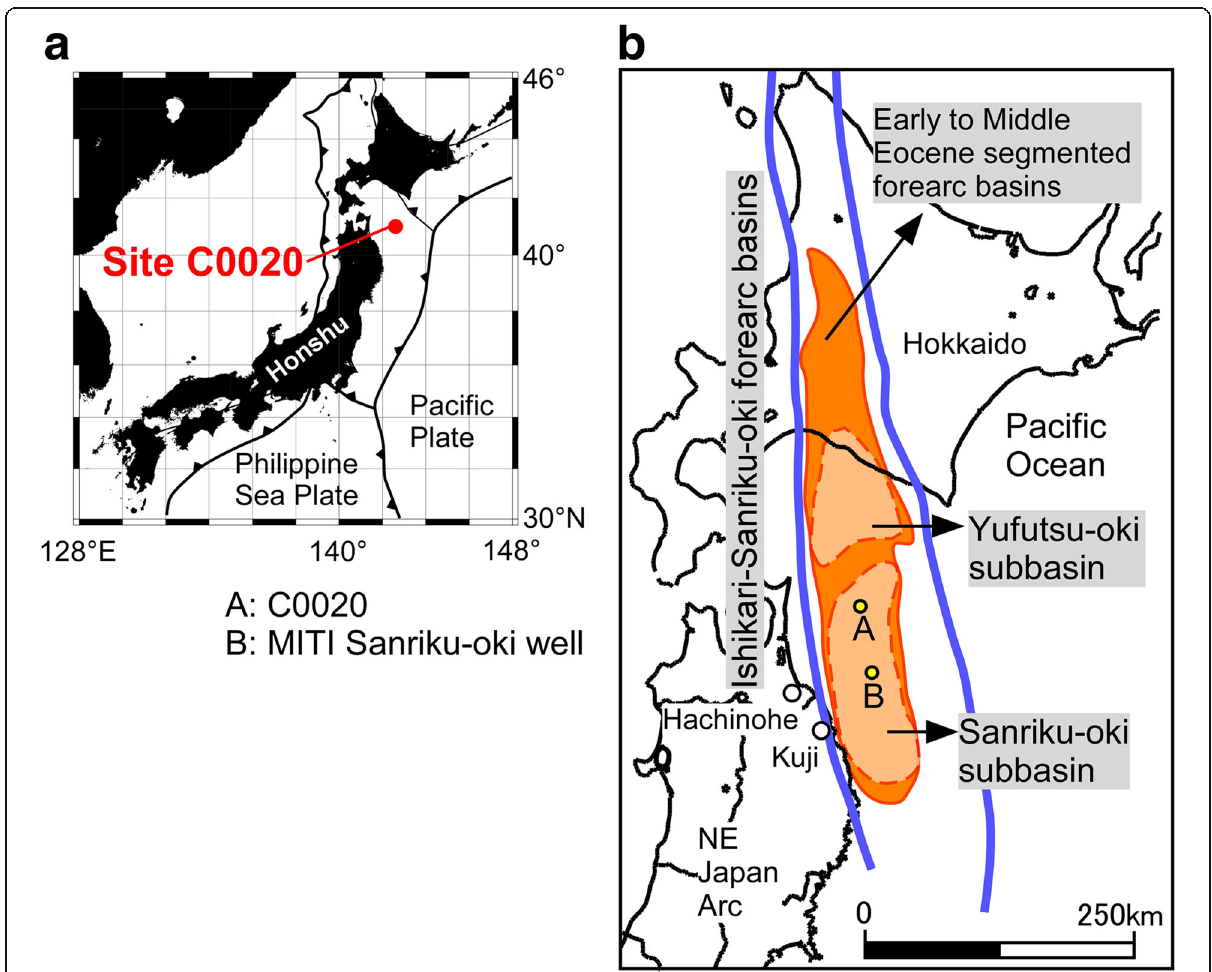
Fig. 1 a Location of IODP Expedition 337 Site C0020A (the same site as Chikyu shakedown cruise CK06-06) (Modified after Inagaki et al. 2012). b A close-up map showing the distribution of the Ishikari-Sanriku-oki forearc basins, the Sanriku-oki subbasin, and the location of the Ministry of International Trade and Industry of Japan (MITI) Sanriku-oki well (Modified after Takano et al.